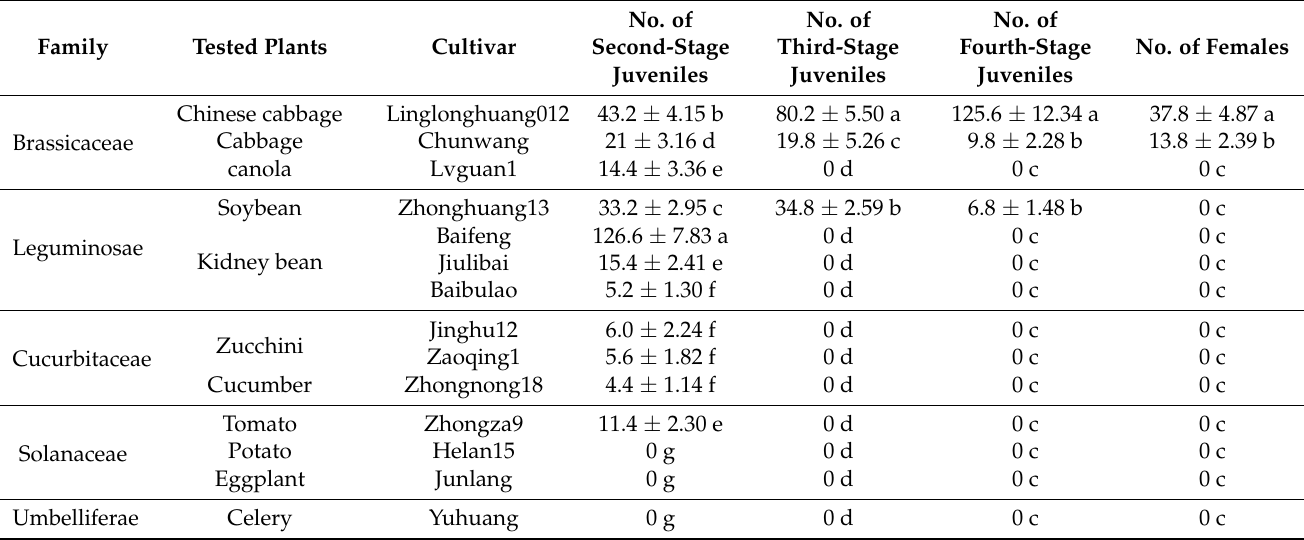
Table 4. Infection of Heterodera schachtii on different